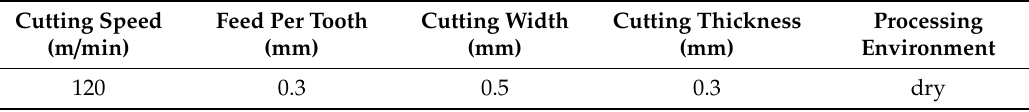
Figure 15. Size of ball-end milling insert. Table 7. Cutting